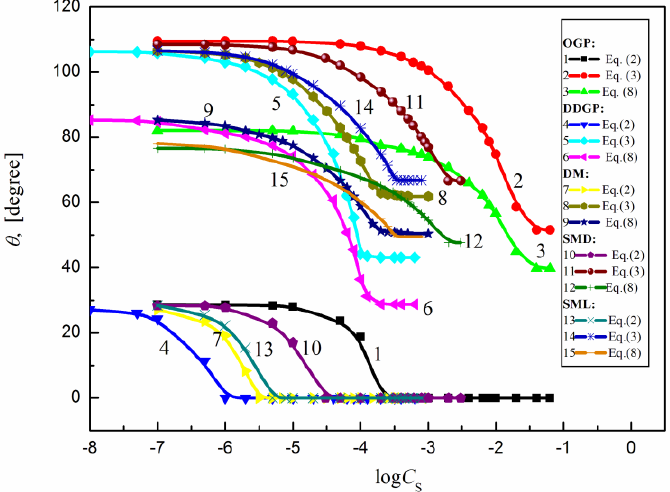
Figure 8. A plot of the contact angle ( θ ) of the aqueous solution of OGP (curves 1–3), DDGP.(curves 4–6), DM (curves 7–9), SMD (curves 10–12) and SML (curves 13–15) calculated from Equation (2) (perpendicular orientation by the hydrophilic head toward the air phase), Equation (3) (perpendicular orientation by the hydrophobic tail of surfactant toward the air phase) or Equation (7) (parallel orientation of surfactant molecules toward the interface region).